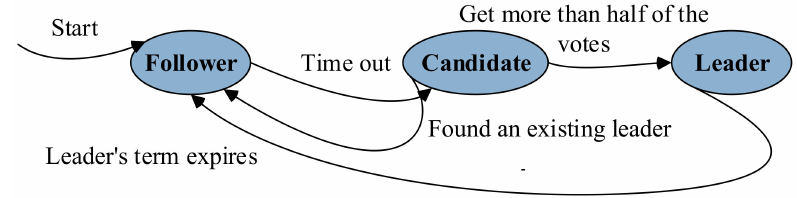
Figure 4. The process of Raft leader election.